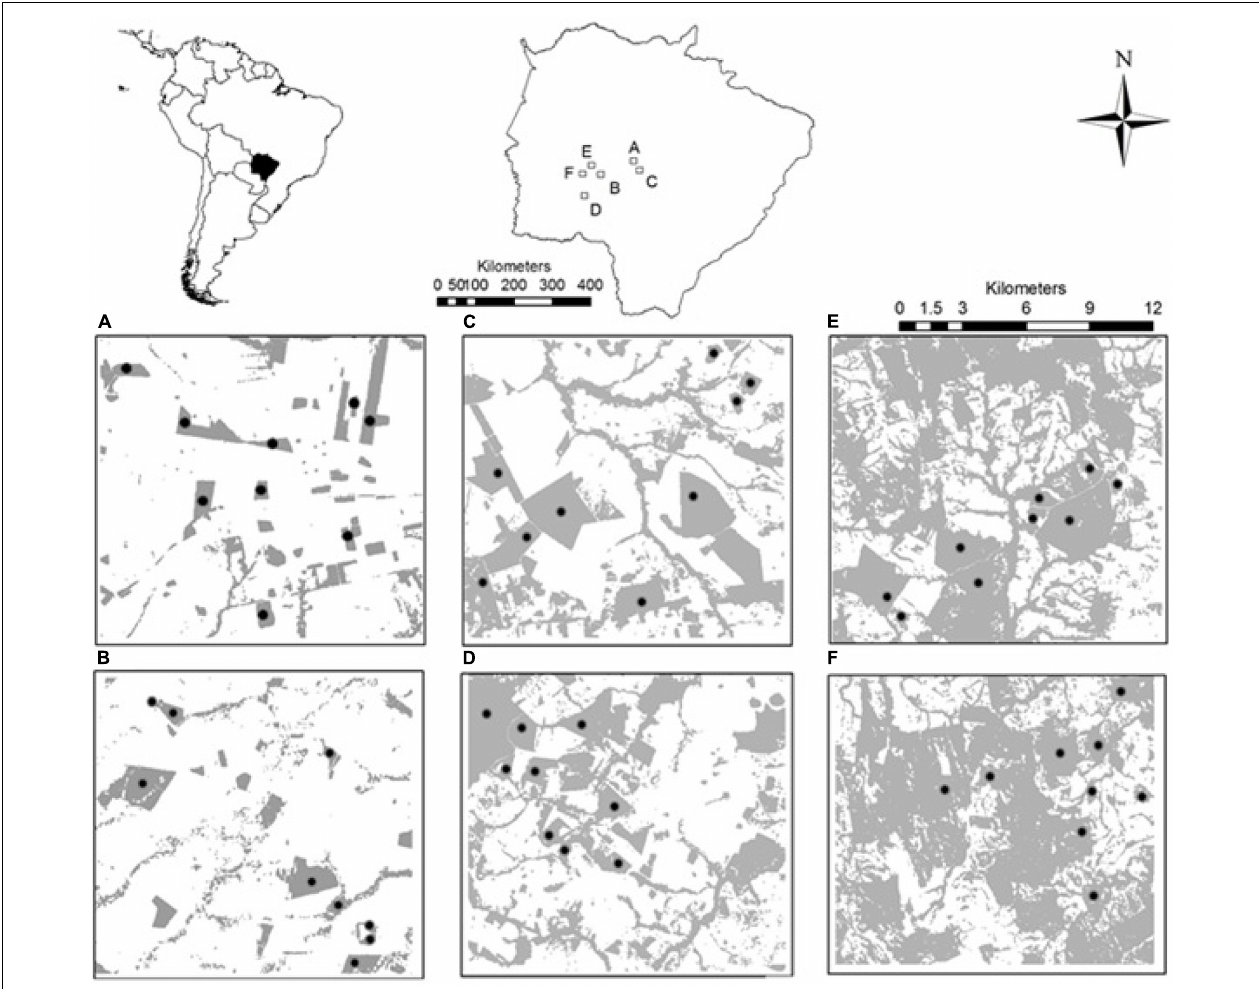
FIGURE 1 | Regional landscapes with 10% (A,B) , 30% (C,D) and 50% (E,F) of habitat amount indicating the distribution of sampled patches (dots). In gray, areas of natural remaining woodland savanna vegetation (“cerradão”). Empty white spaces indicate the matrix around woodland savanna patches which are mainly composed by pastures. The maps on the top situate the study area in South America (left) and the Mato Grosso do Sul state